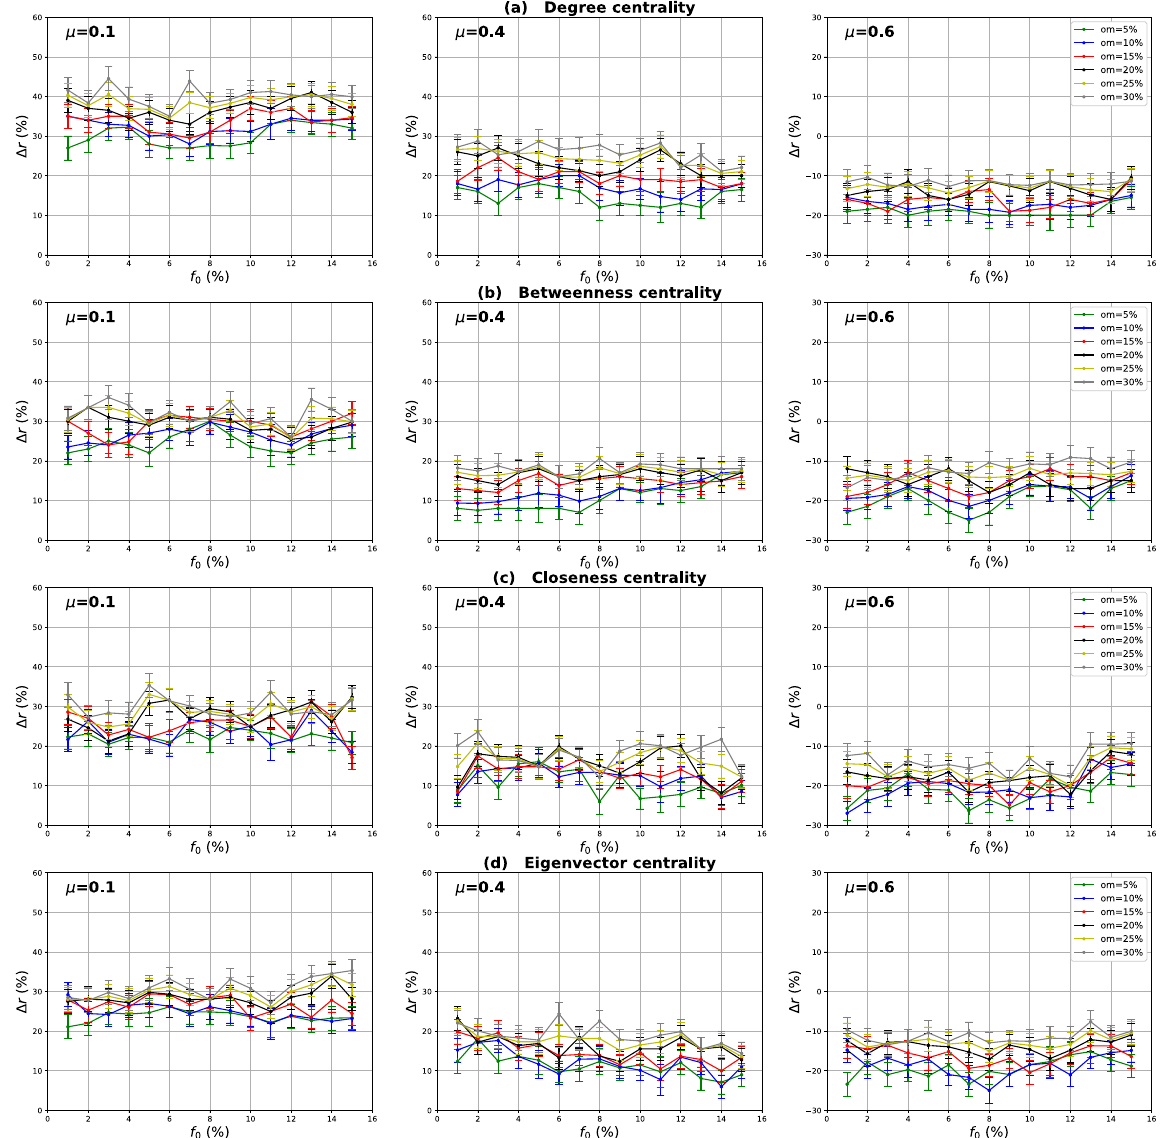
Figure 10. Influence of the community membership degree. The relative difference of the outbreak size Δ r between the standard measure and the Local measure versus the percentage of initial spreaders f 0 . The number of overlapping nodes value on is equal to 10% of the total number of the